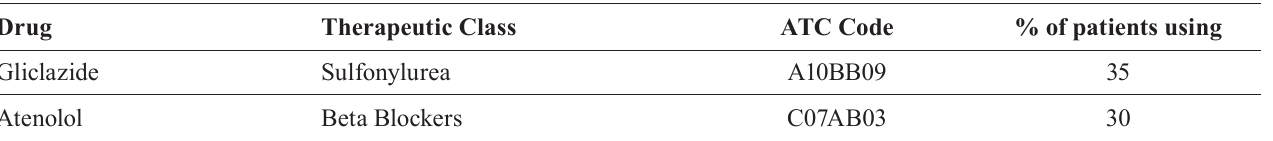
TABLE II - Most prescribed drugs for study patients